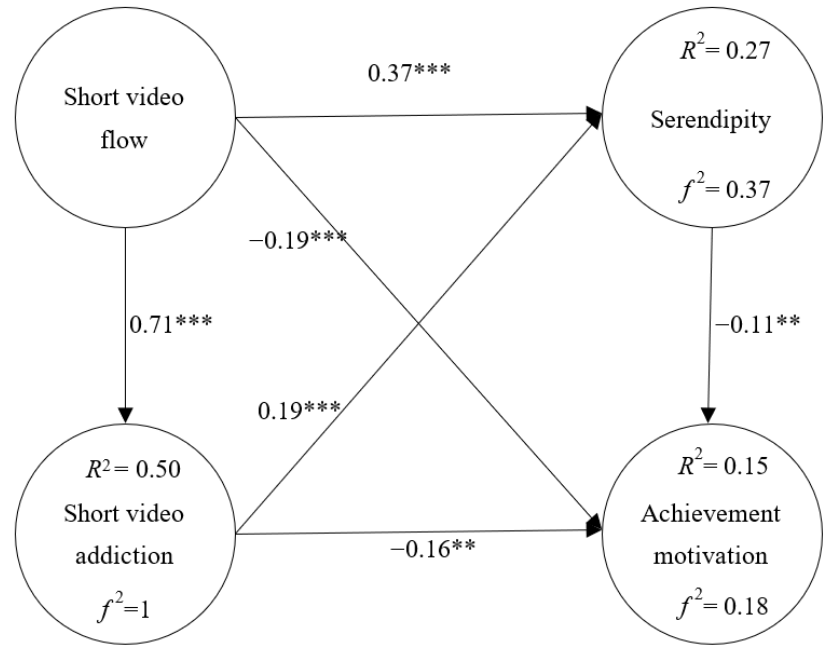
Figure 2. Model Validation. ** p < 0.01, *** p < 0.001.